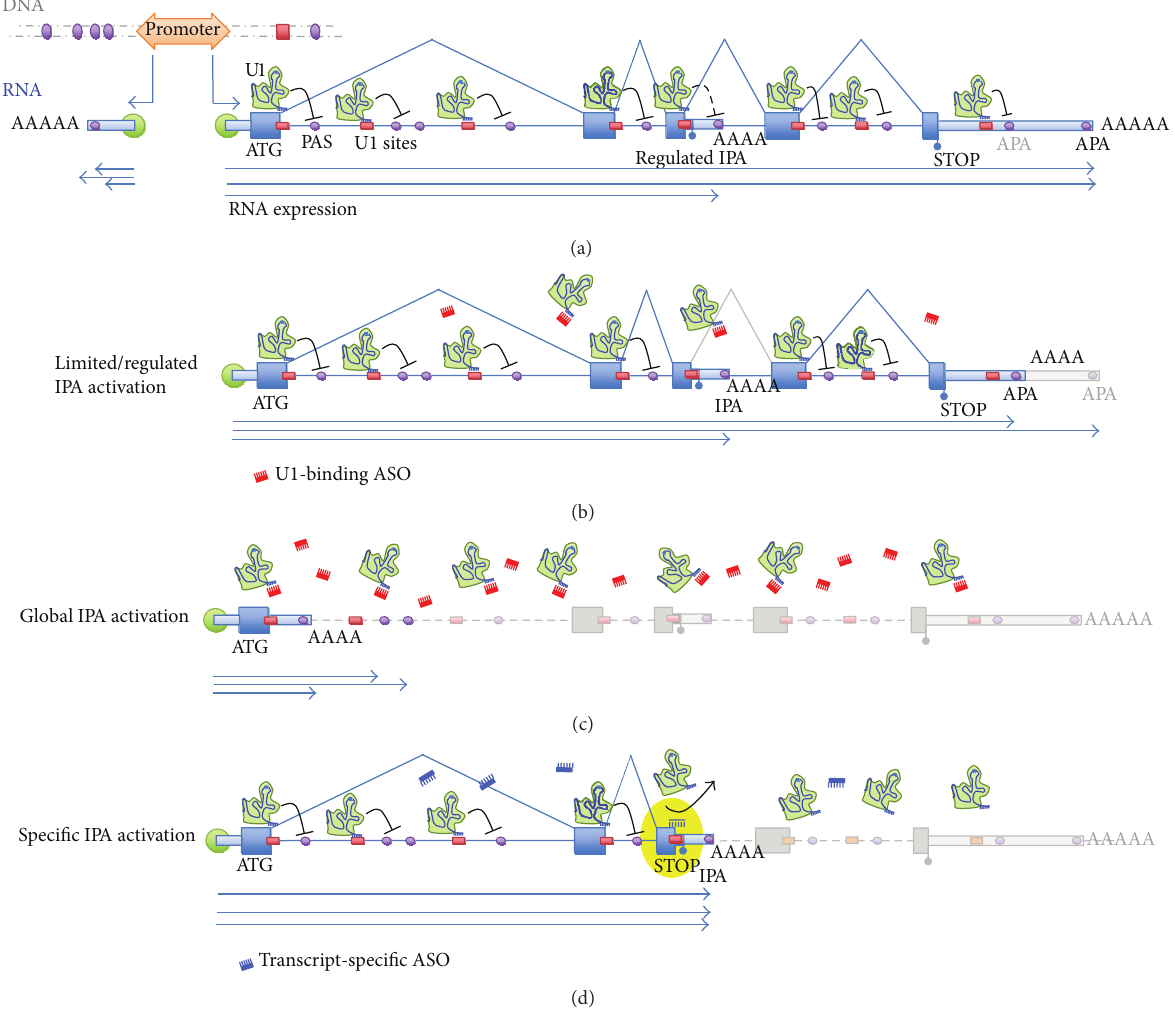
Figure 2: U1 snRNP suppression of cleavage and polyadenylation safeguards transcriptome integrity. (a) In normal conditions, transcription starts bidirectionally from a RNAPII promoter. Relative enrichment of PAS and depletion of U1 sites leads to short nonproductive mRNAs on the antisense strand, thus enforcing promoter directionality (described in Almada et al. 2013 [49]). In the sense strand, the presence of U1-binding motifs at splice sites and along introns recruits U1 snRNP and suppresses IPA, allowing full-length expression. Regulated IPA sites can still be expressed depending on cellular context. (b) Reduction of U1 snRNP activity to levels still compatible with efficient splicing by partial functional knockdown using U1-binding ASOs (described in Vorlov´a et al. [19]) or following changes in endogenous levels [50], leads to selective APA. PASs in stronger context (or suppressed by weaker U1 sites) are activated first. These likely include regulated IPA sites and tandem APA sites, a situation that reflects what may occur in proliferative/cancer cells, with the appearance of shorter average mRNAs in part due to relative shortage of available U1 snRNP. (c) Complete disruption of U1 activity by sequestering ASOs leads to loss of splicing and release of global IPA activation. Because of transcriptional directionality, earlier IPA sites get used first, resulting in massive shortening of mRNAs (described in Kaida et al. [48]). (d) When ASOs targeted to a specific 5 󸀠 ss are used, U1 binding is disrupted in that particular location but still functions normally elsewhere. The result is the selective activation of the targeted IPA site (highlighted), with expression of a truncated variant (described in Vorlov´a et al. [19]). Expression of other genes is not disrupted. U1 snRNP is indicated, as well as U1-targeting ASOs (red) and transcript-specific ASOs, (blue). Large blue and light blue boxes indicate exons and UTRs, respectively, while lines depict introns. PAS are depicted as purple ovals, U1 sites as red bars. Blue arrows indicate mRNA species generated in a specific